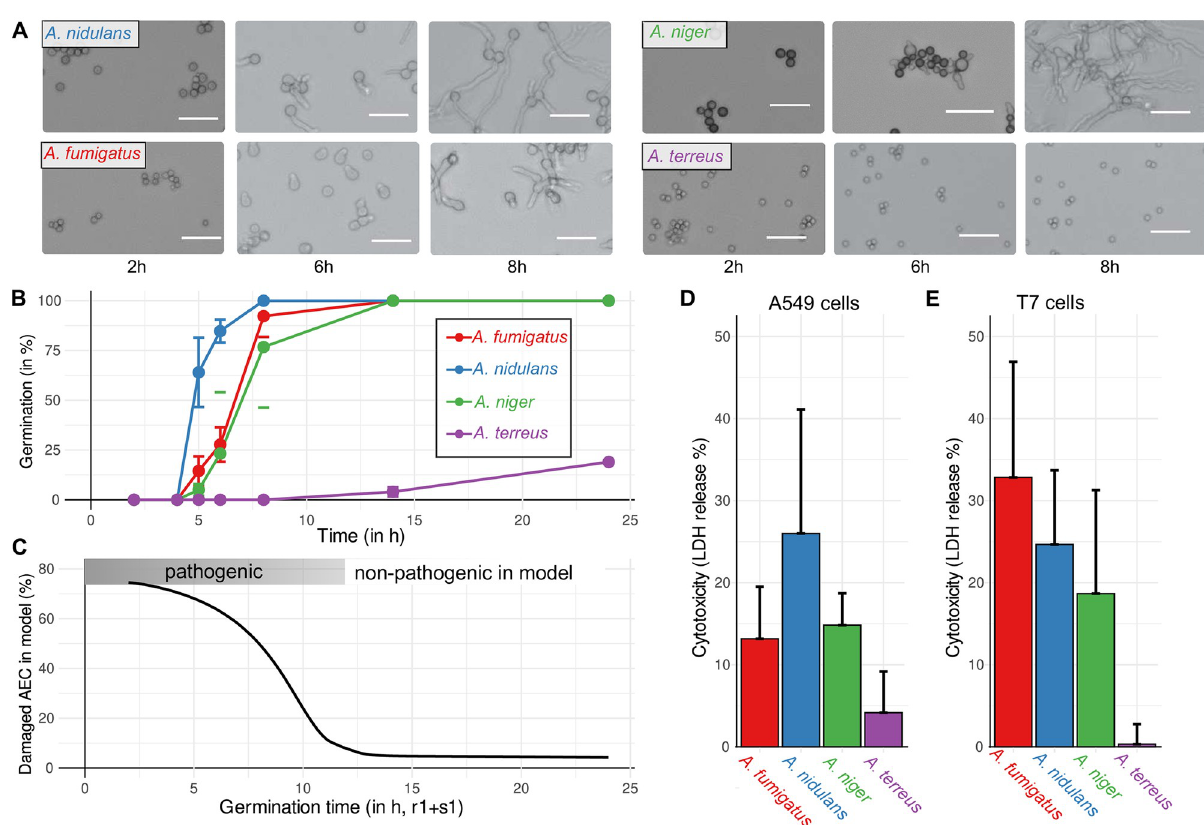
Fig 4. Germination kinetics of Aspergillus spp . and its impact on epithelial cytotoxicity. A Microscopic images (white scale bar, 20 μm ) of germination assays on RPMI medium to automatically count and derive germination kinetics as shown in B for the species A. fumigatus (red), A. nidulans (blue), A. niger (green) and A. terreus (purple). Error bars represent the standard deviation of four replicates. C the relation of germination time and damage of AEC after 24h in the dynamic optimization model and parameter range with expected pathogenicity. Model prediction in C is compared to experimental cytotoxicity of Aspergillus spp . by lactate-dehydrogenase (LDH) release measurements after 24h co-incubation with human A549 epithelial cells in D and with murine T7 epithelial cells in E . Error bars represent the standard deviation of six replicates.